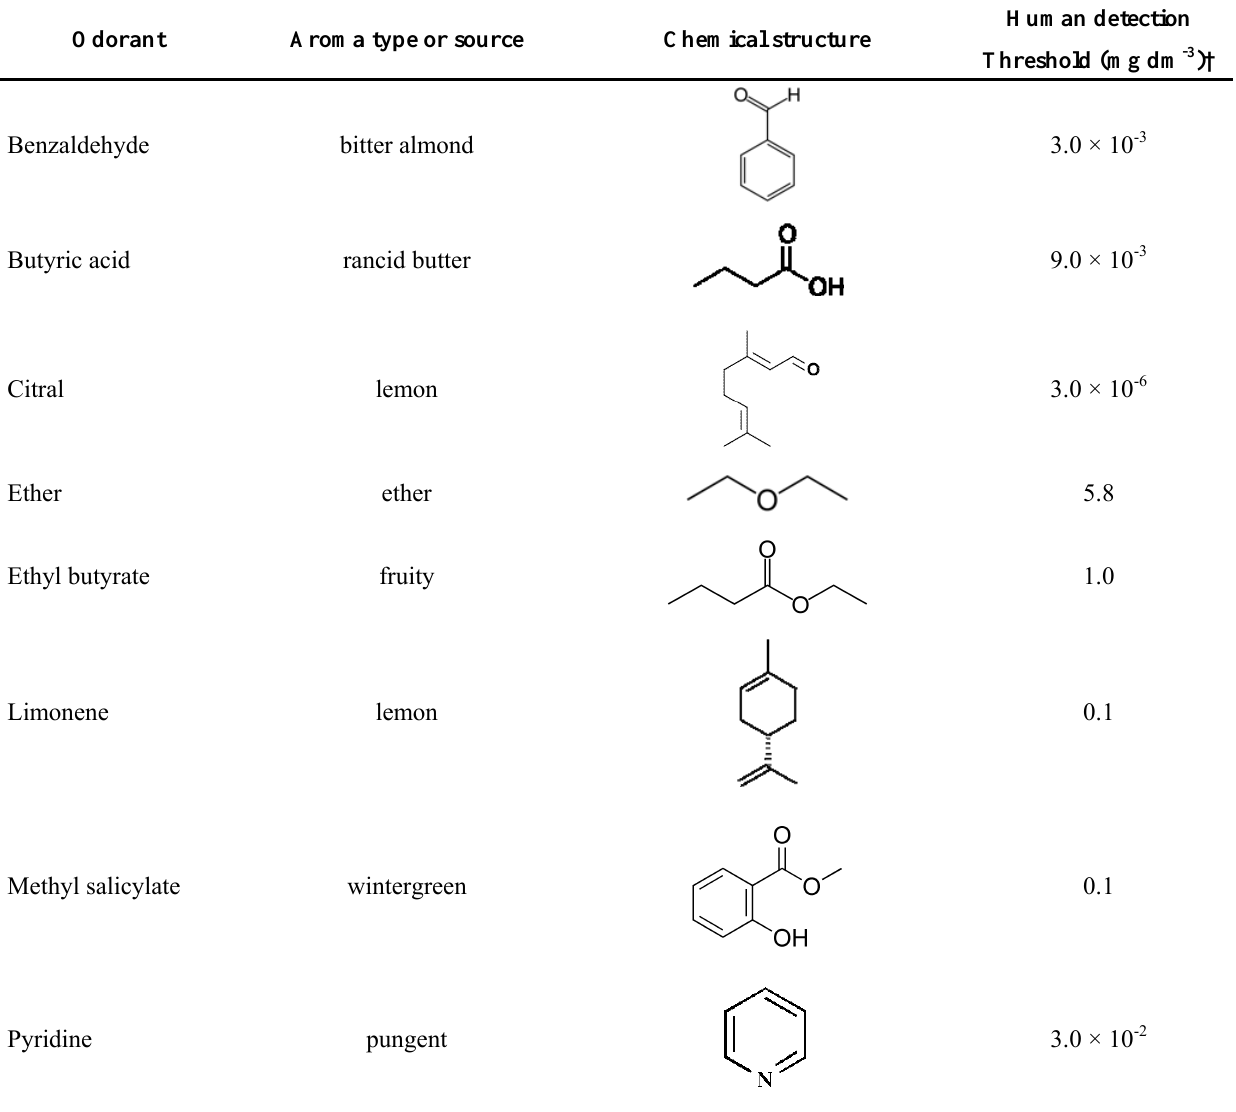
Table 2. Range of human detection thresholds for some common odorants in